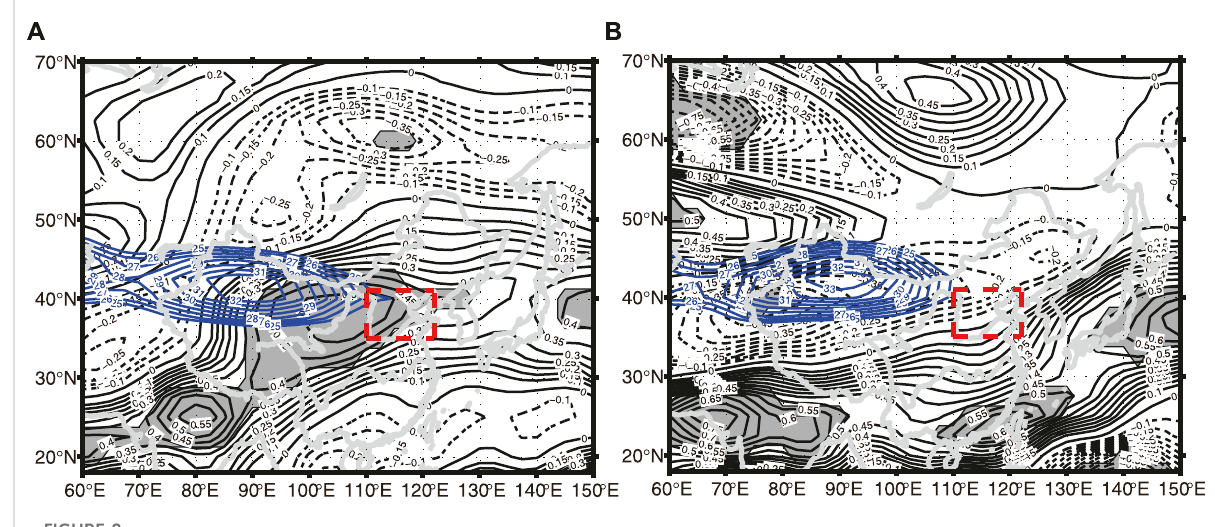
FIGURE 8 CorrelationdistributionsbetweenPDOandzonalwindat200 hPaduring (A) 1979 – 2005and (B) 2006 – 2021.Shadedareasindicatecorrelation reaching 95% con fi dence levels according to Student ’ s t -test. The box shows the region of North China. The blue isolines indicate the zonal wind greater than 25 m/s.